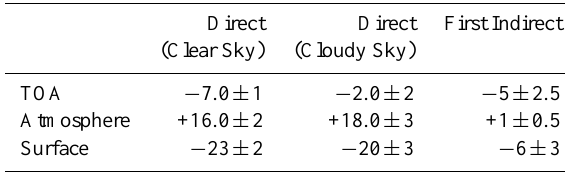
Table 10. Aerosol Radiative Forcing (Wm − 2 ): North Indian Ocean, January–March 1999; 0–20 ◦ N, τ a =0.3 (based on plate 13 of Ramanathan et al., 2001, copyright 2001 by the American Geo- physical Union, adopted with